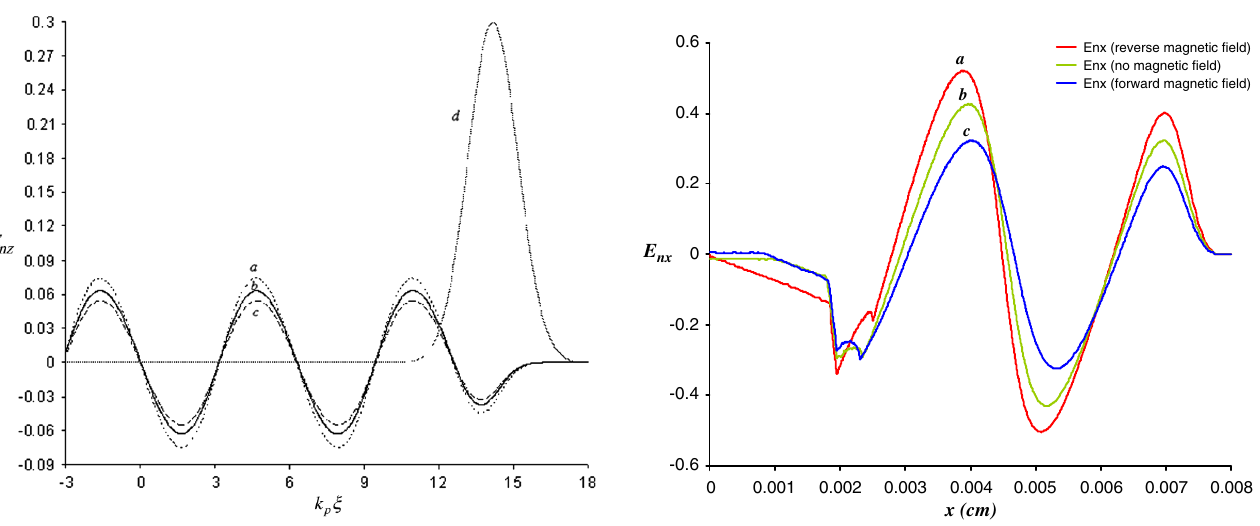
FIG. 5. Variation of normalized longitudinal electrostatic Þ with x for (cid:1) ¼(cid:4) 1 (curve a ), (cid:1) ¼ 0 (curve b ), wakefield ð E nx and (cid:1) ¼ þ 1 (curve c ) for a 0 ¼ 1 : 0 using 2D XOOPIC simulation code.